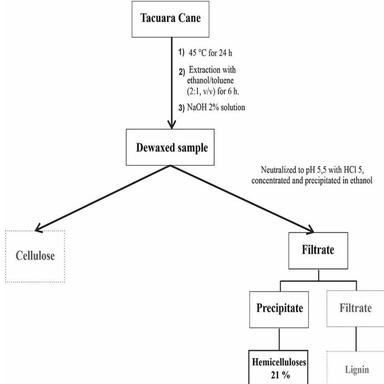
Simplified procedure for the extraction of HC.